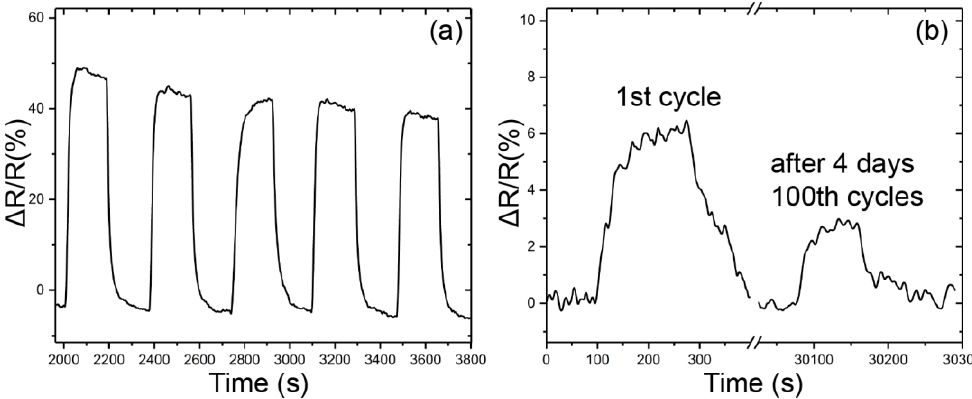
Figure 10. ( a ) Reversibility test for PEG/MWCNTs upon exposure to 50% diluted acetone; ( b ) Degradation of the sensor after 100 cycles upon exposure to 100 ppm of acetone.